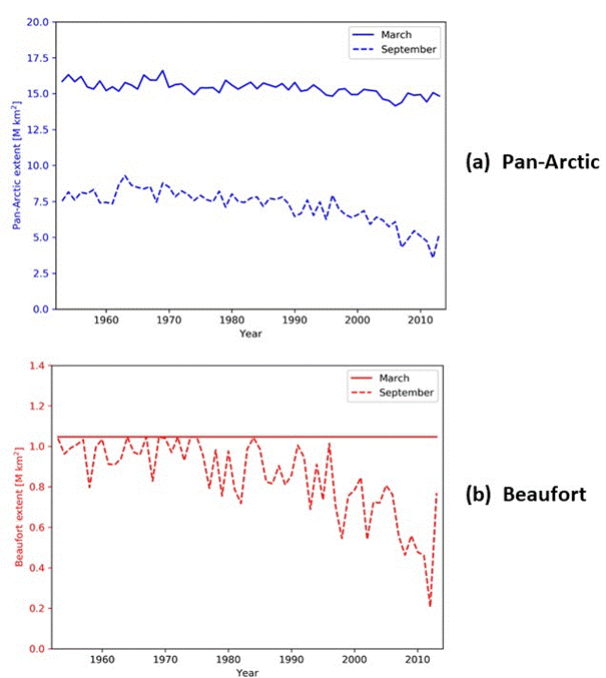
Figure 3. (a) Total Arctic sea ice extent and (b) the extent of ice in the Beaufort Sea during March (solid lines) and September (dashed